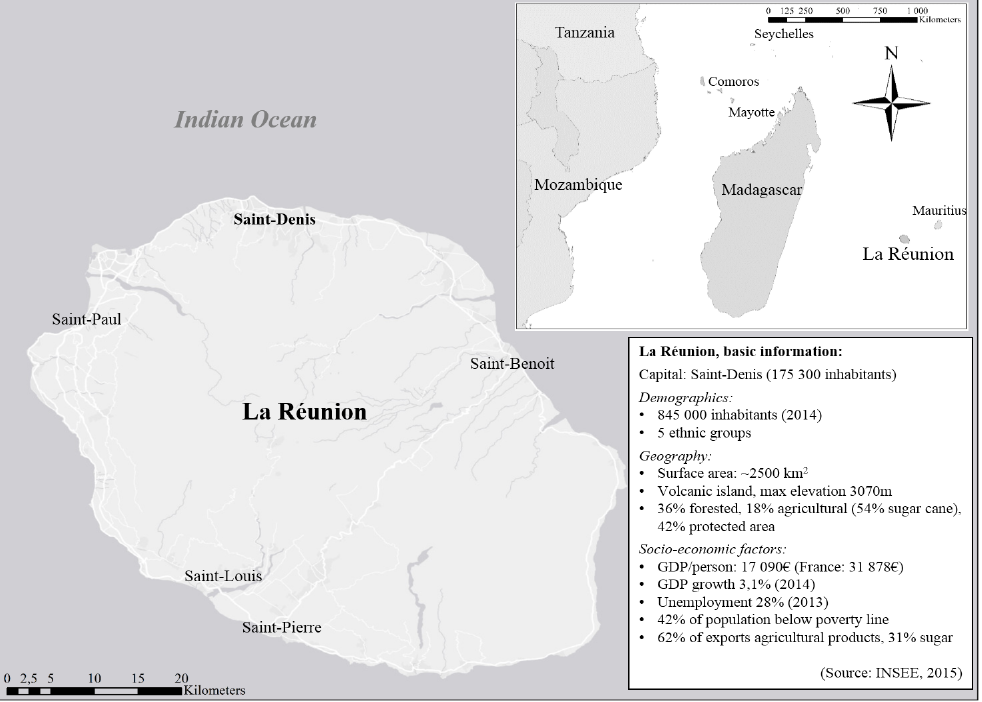
Fig. 1. Location of Reunion Island (La Réunion) and basic environmental and socio economic data (background map data: